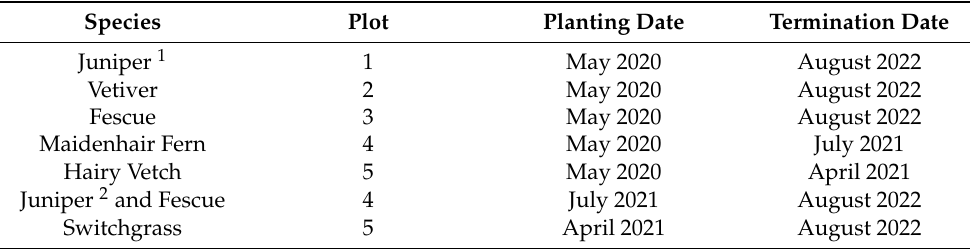
Table 1. Species planting dates in experimental plots. Plot numbers are described in Figure 3. Species